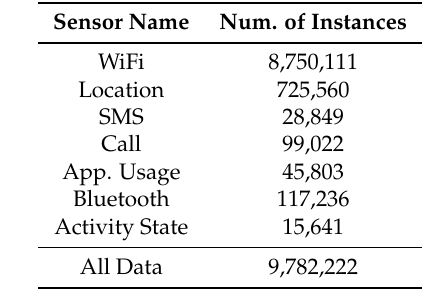
Table 1. Number and types of sensors in the UbiqLog dataset.